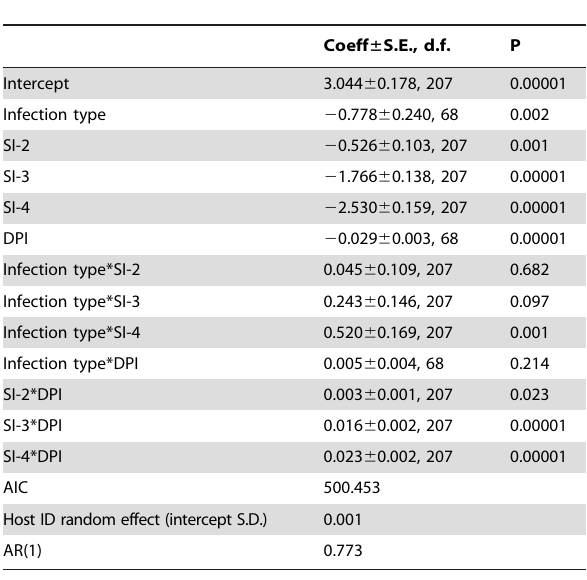
Table 2. Summary of linear mixed effect model (LME) between T. retortaeformis abundance (worm/small intestine length) as a response, and infection type (single or co- infection), day post infection (DPI) and organ location (from the duodenum -SI1- to the ileum -SI4-), as independent